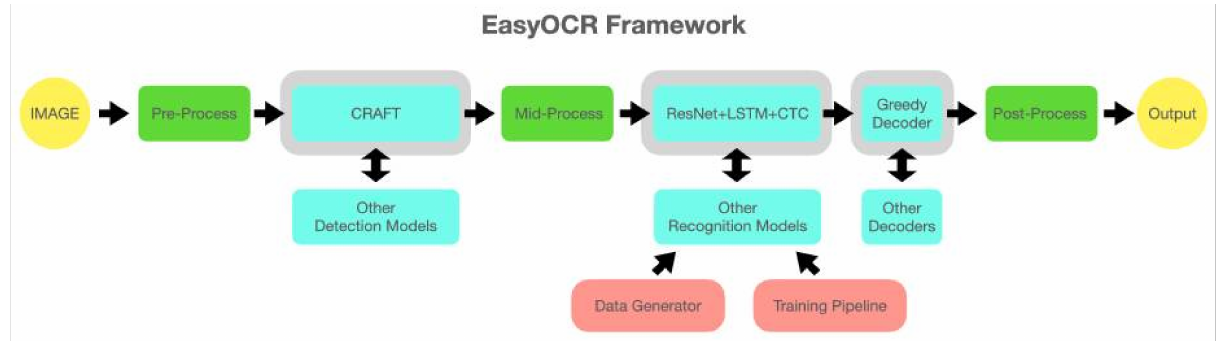
Figure 2. EasyOCR pipeline